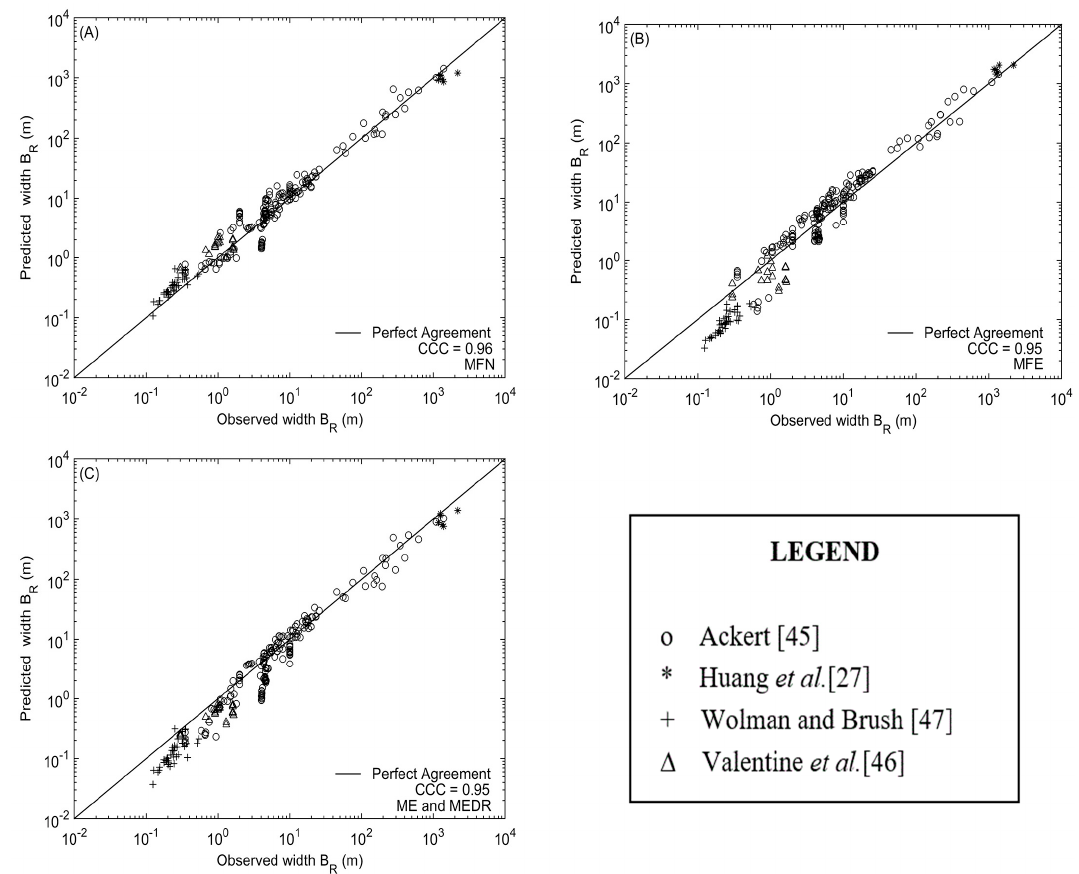
Figure 1. Comparison of predicted and observed widths B R for sand bed channels [27,45–47]. ( A ) MFN; ( B ) MFE; ( C ) ME and MEDR.